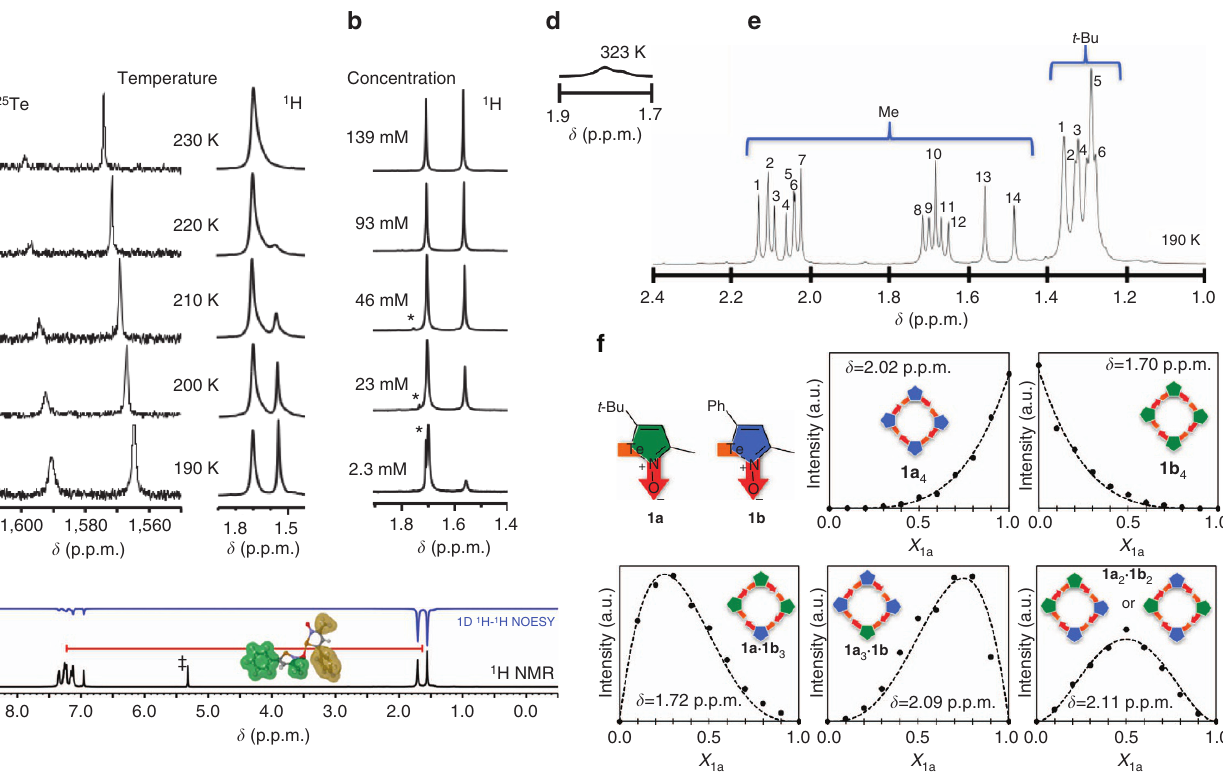
Figure 4 | NMR Investigations of the auto-association of 1 in solution. NMR (500MHz) spectra of 1b solutions in CDCl 3 : ( a ) 125 Te and 1 H at 74mmoll (cid:2) 1 and variable temperature; ( b ) 1 H at 190K as a function of concentration; *denotes the resonance of a trace amount of H 2 O. ( c ) 1 H-NMR and 1D-NOESY spectra of 1b in CD 2 Cl 2 at 190K; the over-imposed structure portrays the van der Waals surfaces of the methyl and phenyl groups of each molecule in a pair modelled with coordinates extracted from the crystal structures of 1b 4 ; z denotes the resonance of residual CHDCl 2 . 1 H-NMR (600MHz) from the equimolar mixture of 1a and 1b : ( d ) methyl resonances above room temperature, ( e ) methyl and t -butyl resonances at low temperature. ( f ) evolution of selected methyl 1 H-NMR lines as a function of composition (molar fraction of 1a ) of the mixtures, dashed lines correspond to the calculated abundance of each type of aggregate.